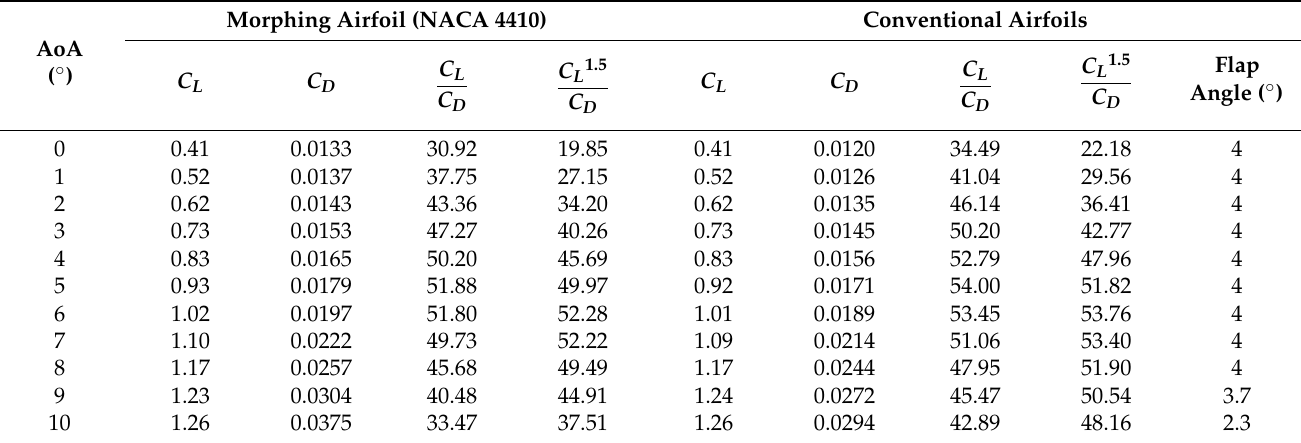
Table 3. Aerodynamic data of morphing (NACA 6410) and matching C L conventional